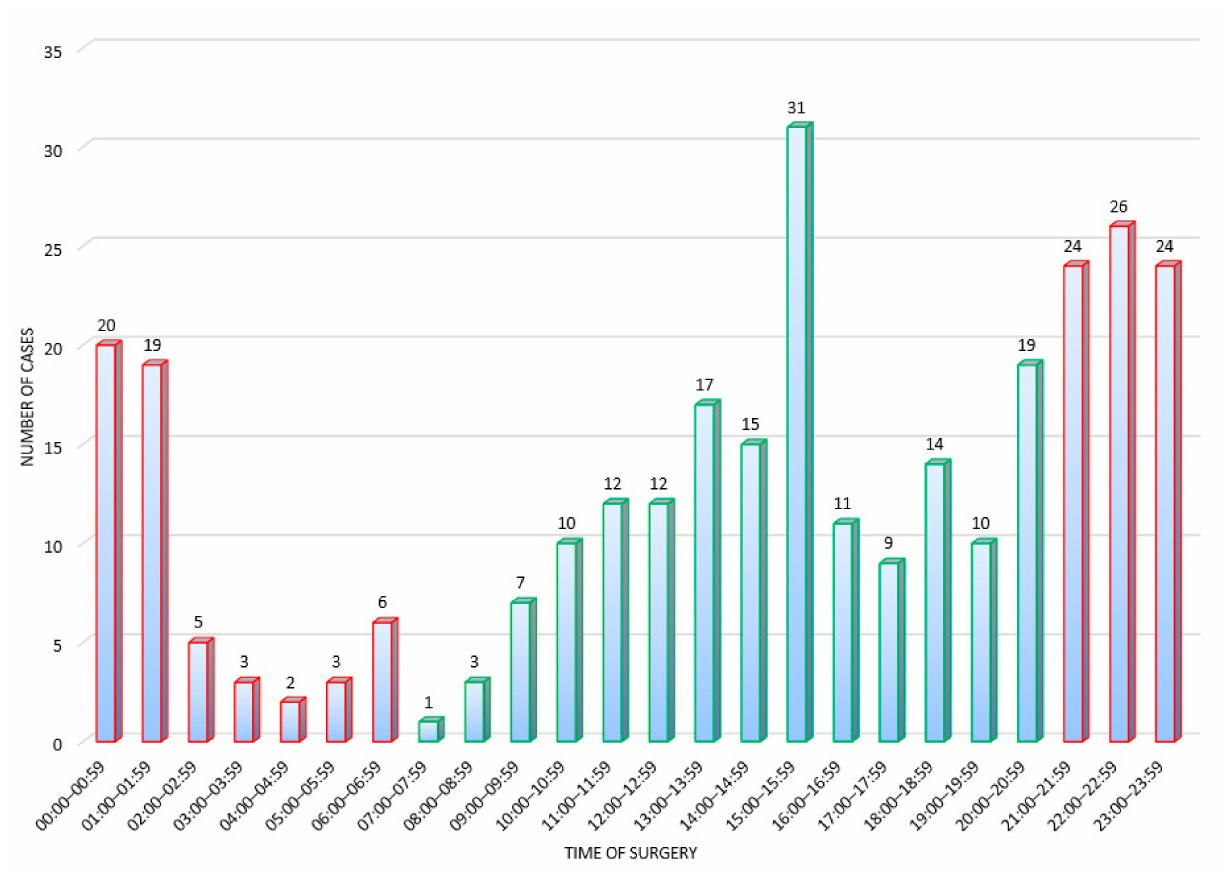
Figure 2. The hour proportion of patients with acute appendicitis in regard to the time of surgery (green bars—daytime; red